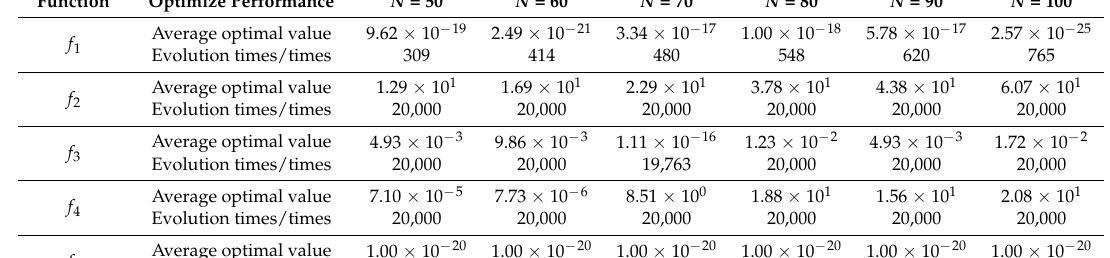
Table 5. Influences of convergence performance with different harmony tone components of the SC-AHS algorithm.